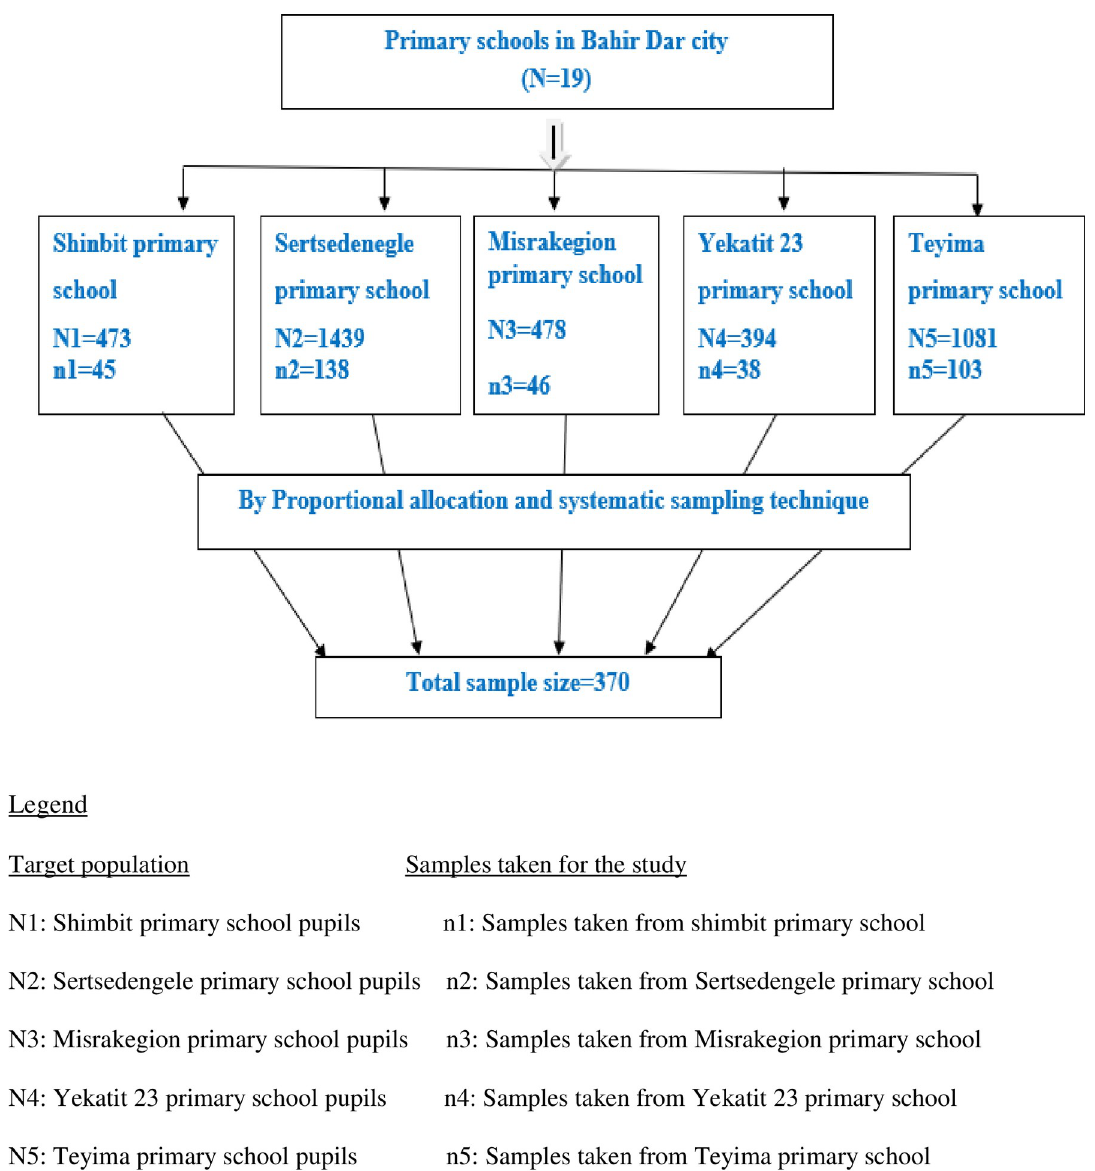
Underweight. The pupil was classified as underweight if the weight- for-age was � -2 SDs from median growth standards of WHO